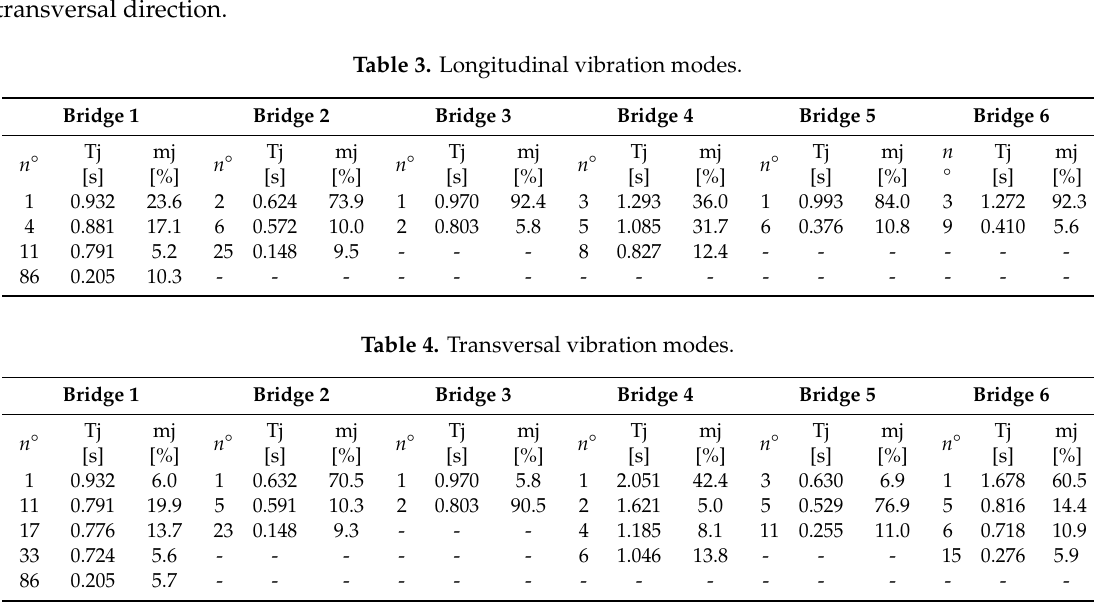
Table 2. Idealized shear-displacement plastic hinge laws (Z direction).